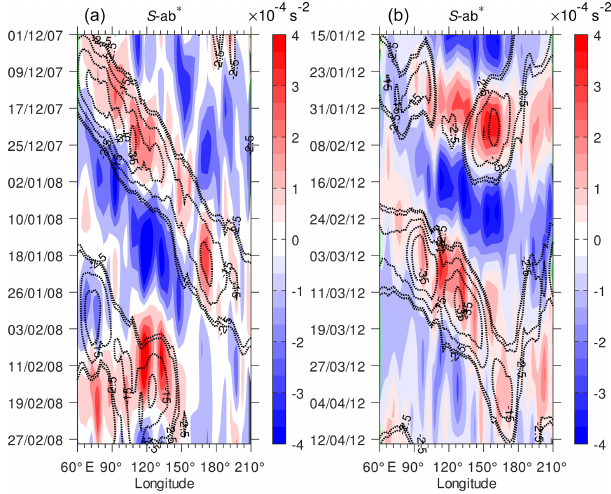
Figure 13. Mean N 2 profiles during MJO active (blue) and MJO inactive (red) phases (a) and their difference (b)